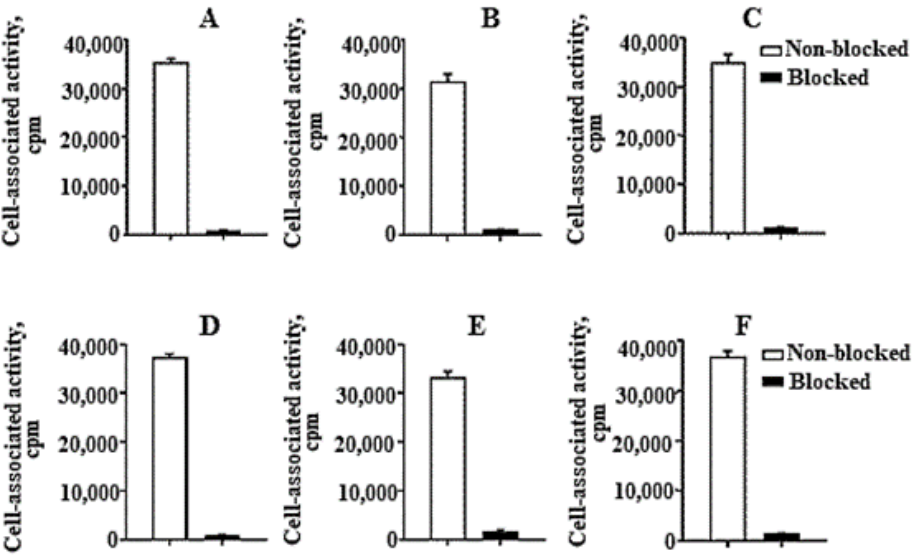
Figure 4. In vitro binding specificity of ( A , D ) [ 99m Tc]Tc-ZHER2:41071, ( B , E ) [ 99m Tc]Tc-ZHER2:V2 and ( C , F ) [ 99m Tc]Tc-ZHER2:2395 to HER2-expressing SKOV3 ( A – C ) and BT-474 ( D – F ) cell-lines. For the pre-saturation of HER2, a 500-fold molar excess of a non-radioactive affibody molecule was added. The data are presented as an average value from three samples ± SD.